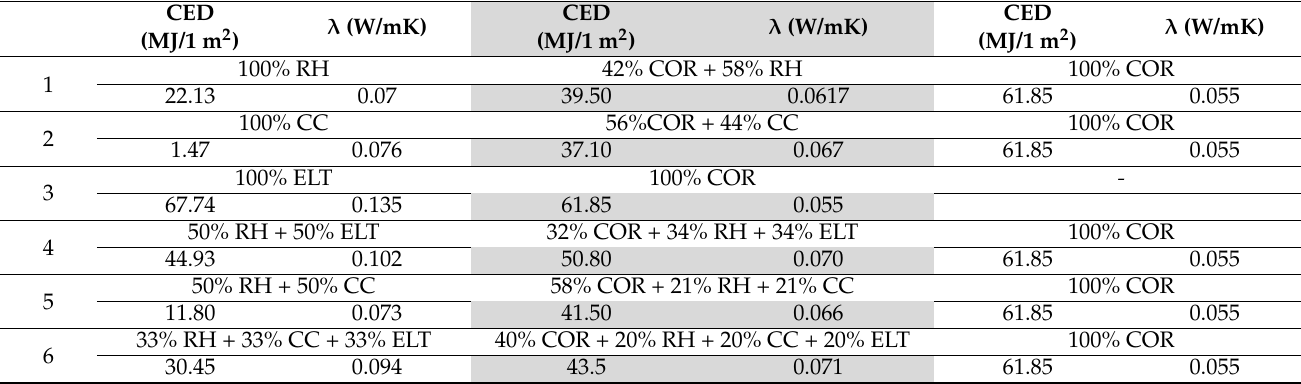
Table 9. Cumulative Energy Demand and Thermal conductivity values obtained for the best identified mixture (in the grey column the best mixing ratios are